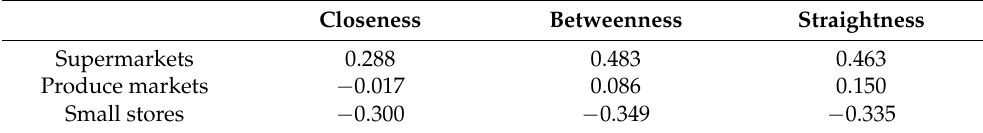
Table 1. Moran’s Index values for road network centrality indices for food retail outlets. Closeness Betweenness